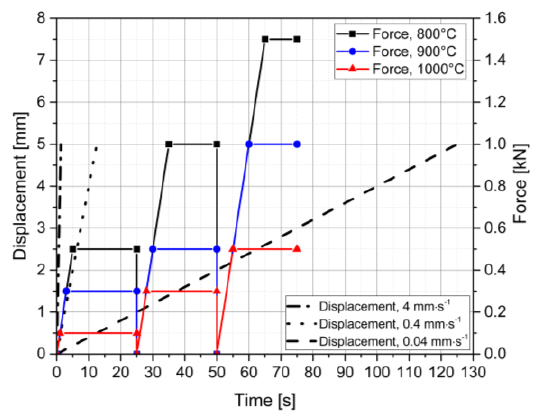
Figure 2. Process control curves for displacement- and force-controlled experiments at 800, 900, and 1000 °C.